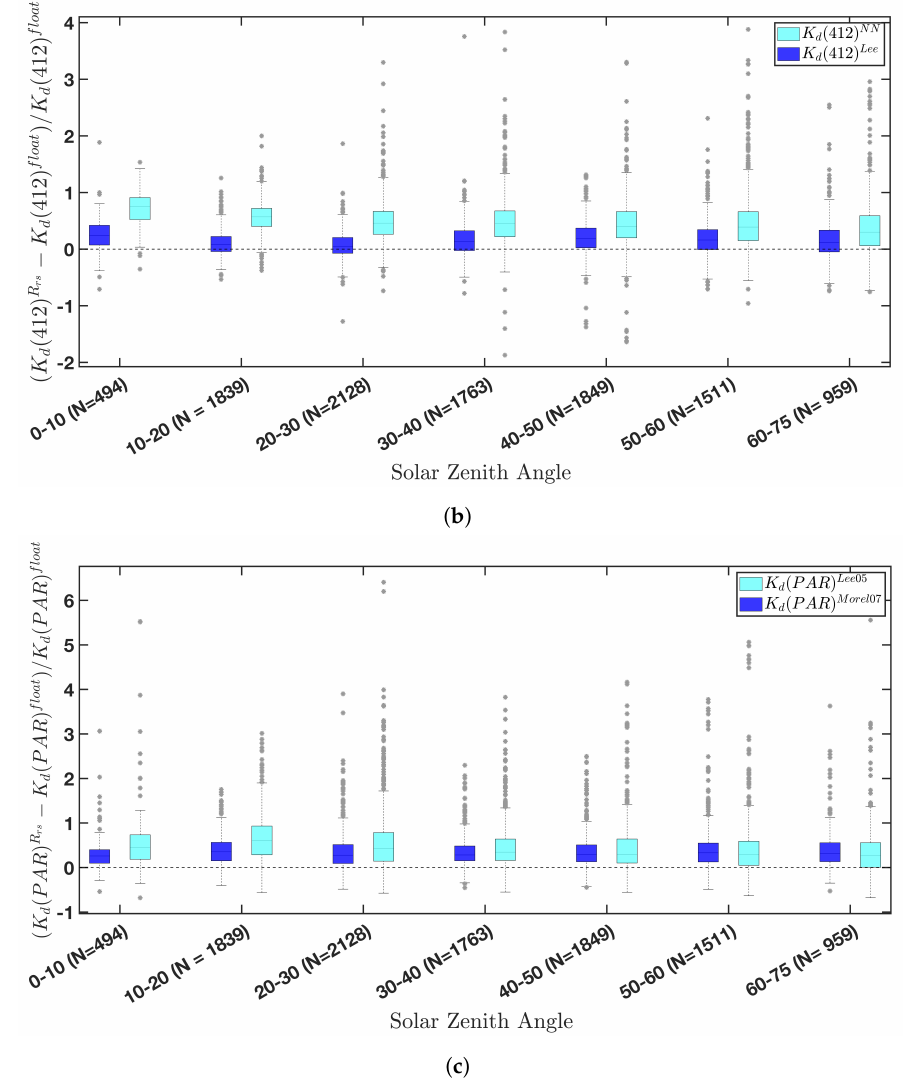
Figure 6. Boxplot of the relative residuals between satellite-derived and float-derived K d ( λ ) and its dependence on the solar zenith angle for: ( a ) 490 nm; ( b ) 412 nm; and ( c ) PAR. Color denotes the algorithm used. Datapoints for 412 nm with residuals value higher than 0.8 were considered to be outliers and were not plotted here for